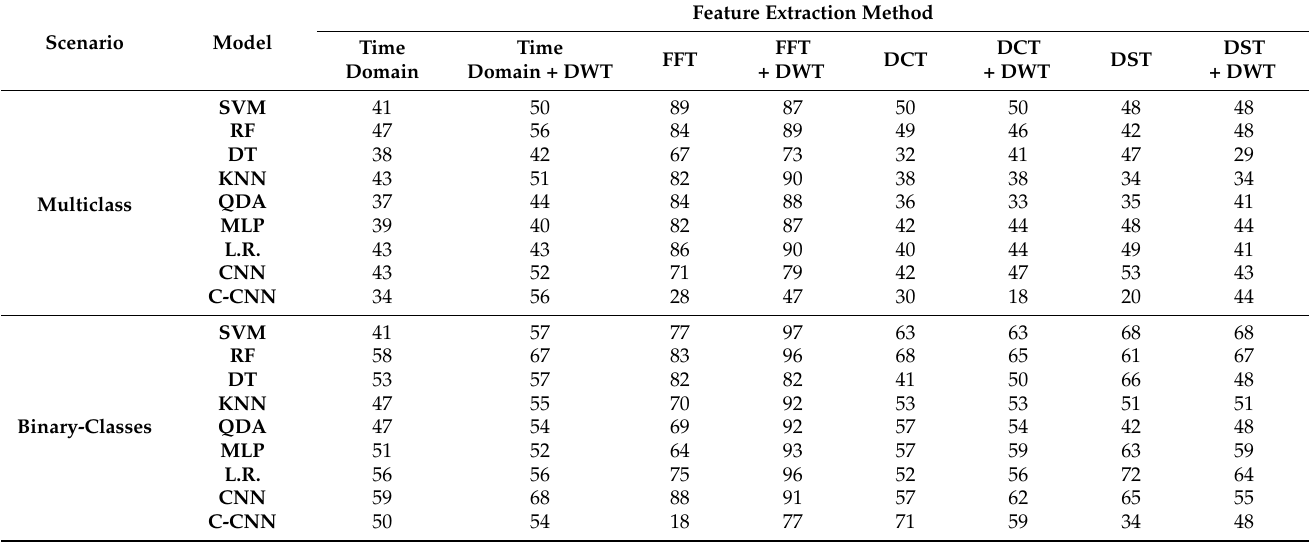
Table 3. Brief Comparison among The Precision of The Proposed Machine Learning Models in Different Domains.